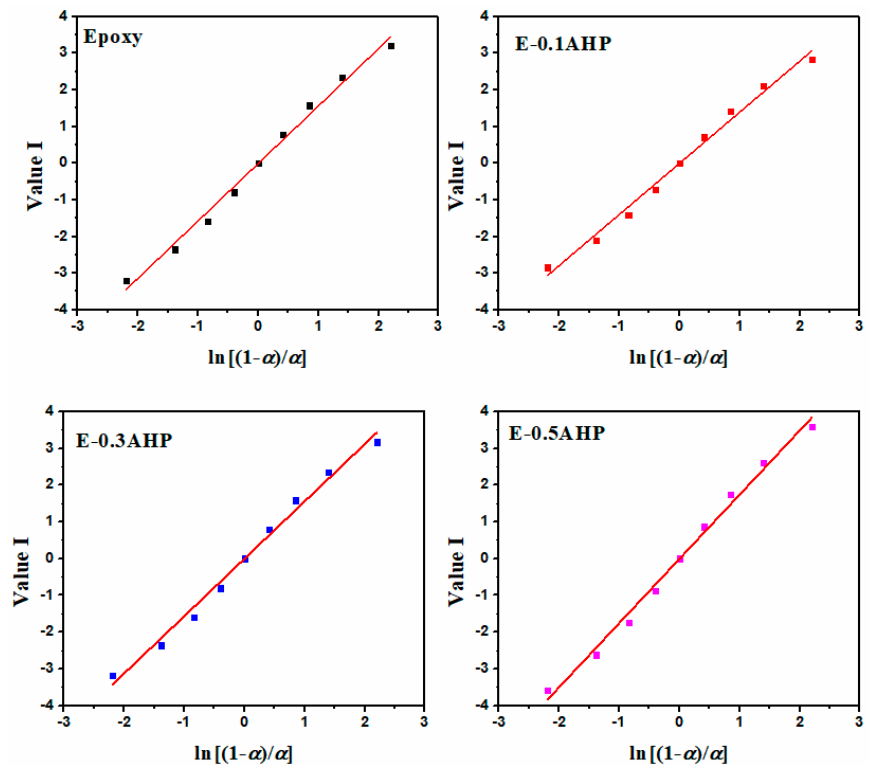
Figure A5. Plots of Value I calculated using DSC data for prepared epoxy system under heating rate of 5 °C/min.